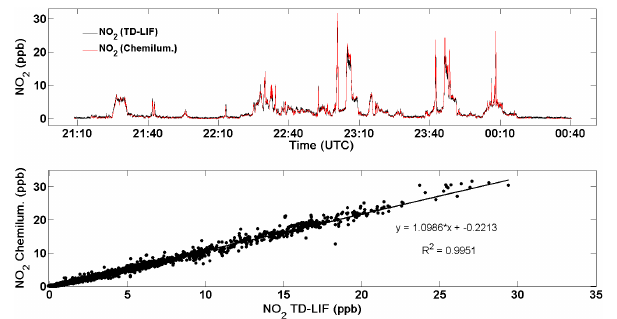
Figure 10. Upper panel: time series of measurements on board the research aircraft BAe 146-2 Fig. 10. Upper panel: time series of measurements on board the 301 of ∑PNs and N 2 O 5 detected by the TD-LIF and by the BBCEAS, respectively. 3 research aircraft BAe 146-301 of P PNs and N 2 O 5 detected by the Lower panel: scatter plot of ∑PNs and N 2 O 5 reported in the upper panel of this figure. 4 TD-LIF and by the BBCEAS, respectively. Lower panel: scatter plot of P PNs and N 2 O 5 reported in the upper panel of this